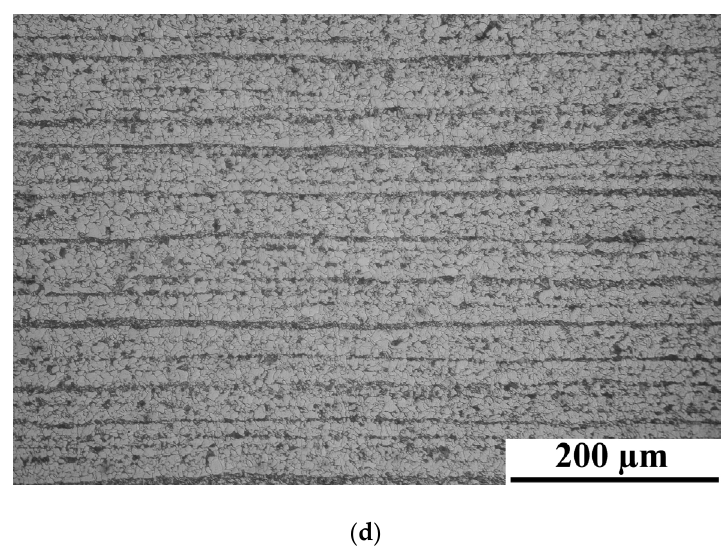
Figure 10. Optical micrographs of: ( a ) specimen SA; ( b ) specimen SW; ( c ) middle area of specimen SW— the tempering effect and ( d ) S460N microstructure.